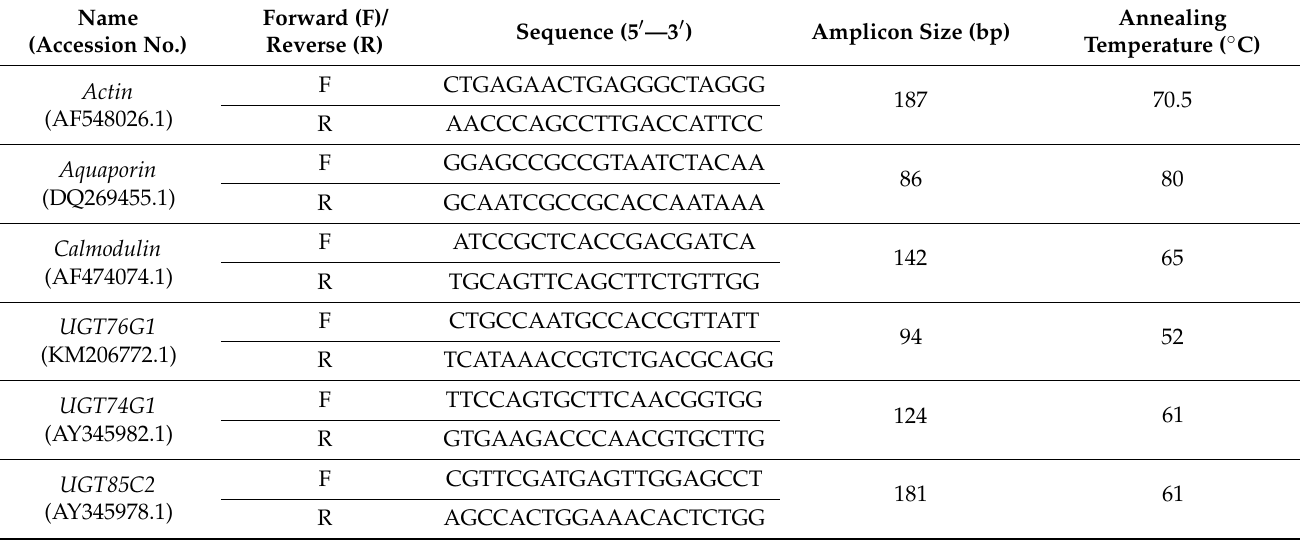
Table 4. Details of the designed primers used to detect the expression level of targeted and reference genes in qPCR.